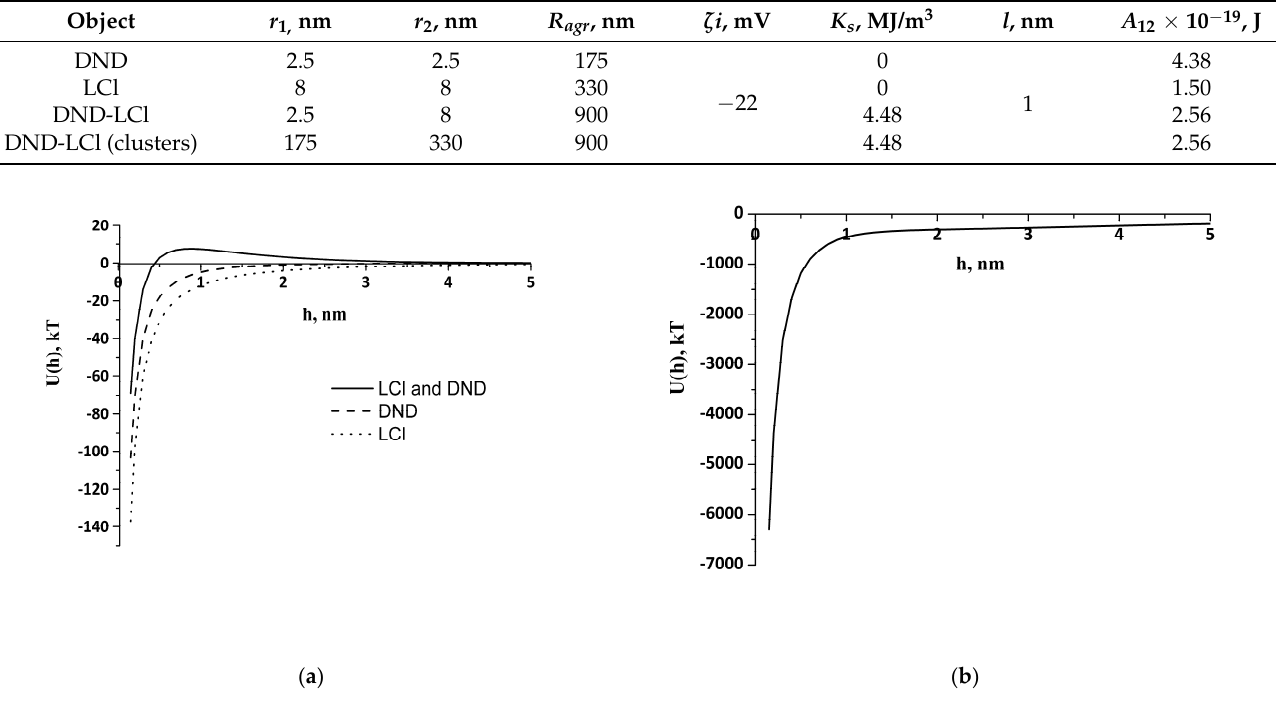
Figure 3. Energy of interaction: ( a ) between the nanoparticles; ( b ) between the clusters of the LCl and DND nanoparticles.